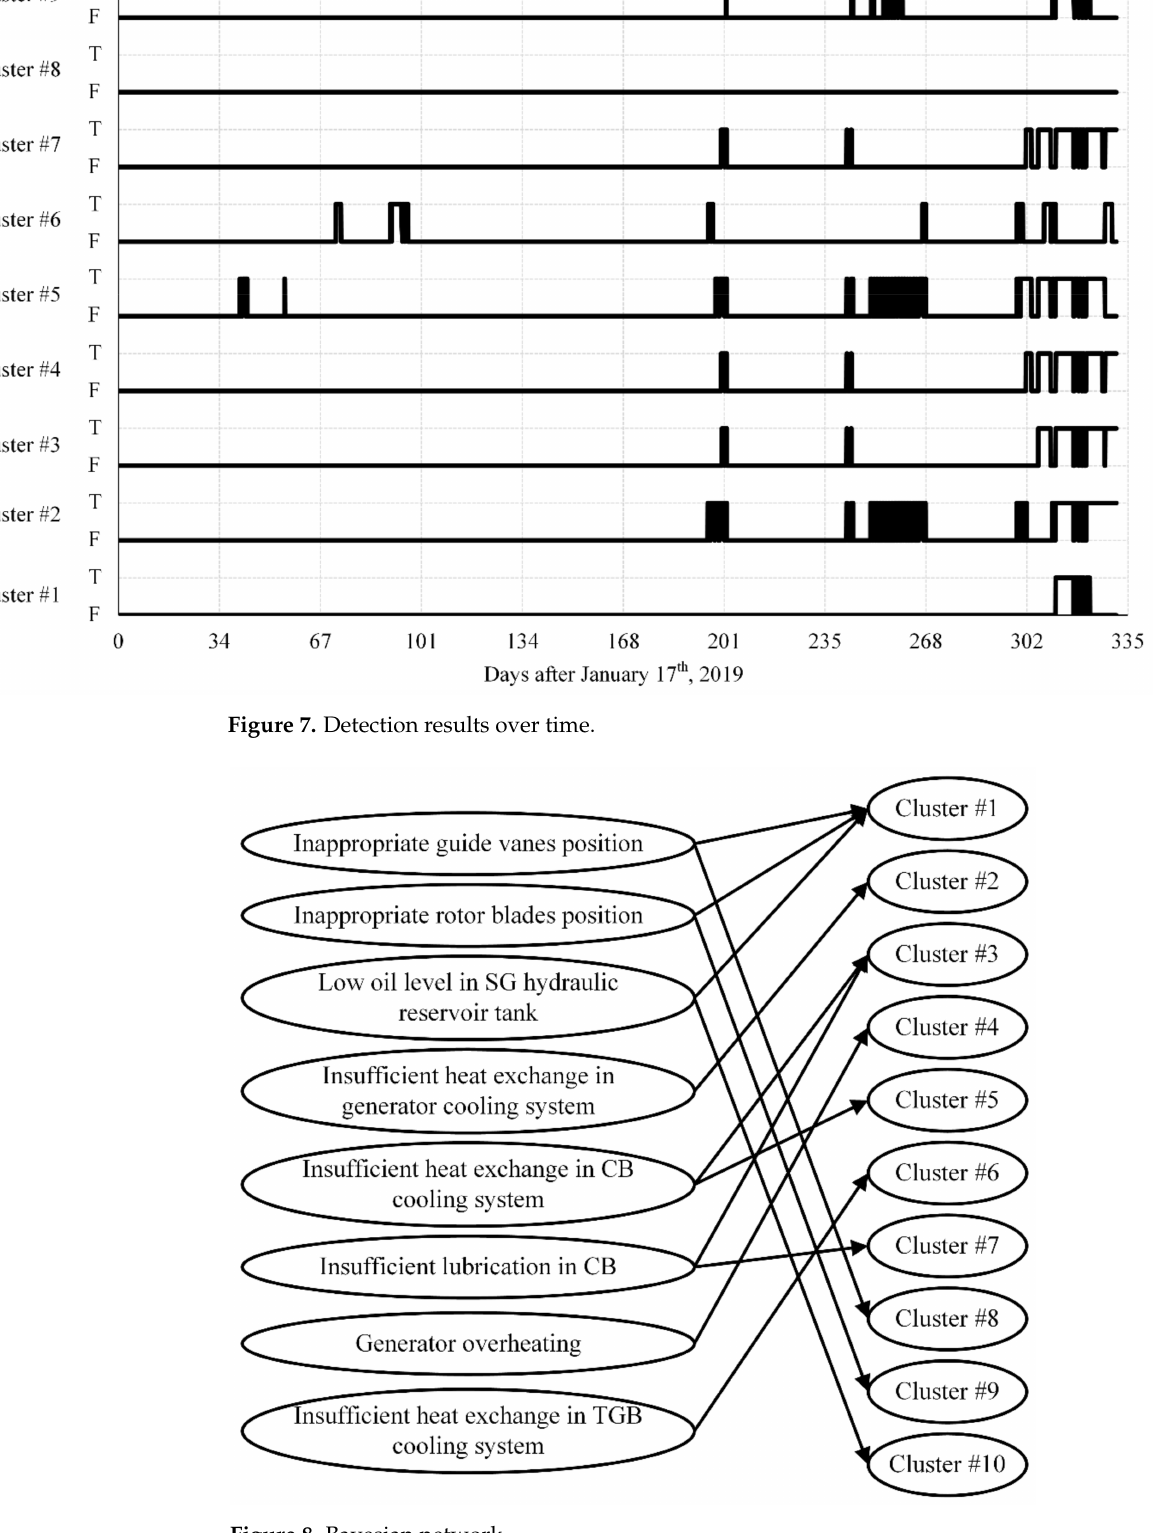
Figure 8. Bayesian